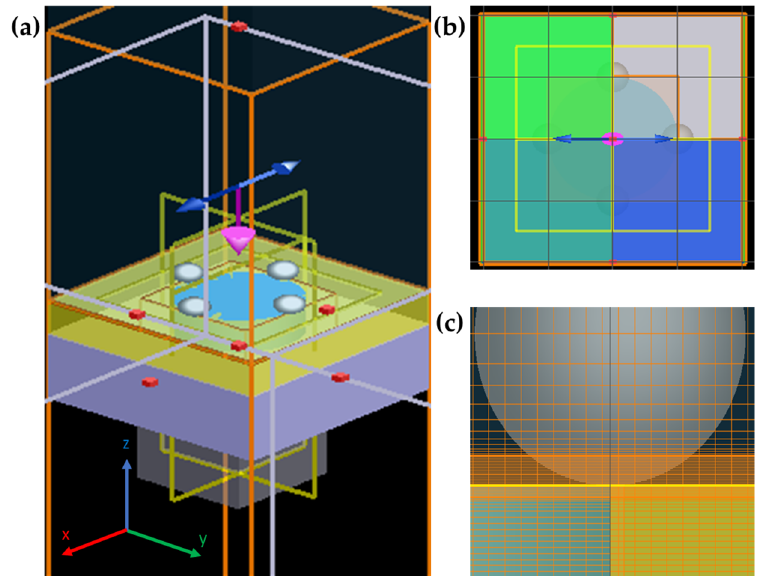
Figure 2. FDTD simulation of the hybrid SERS active nanostructure. ( a ) Perspective view of the simulation environment showing the light polarization in the x -direction. ( b ) Symmetric and antisymmetric boundary conditions were set for the x - and y directions, respectively, and a perfectly matched layer (PML) was set in the z -direction. ( c ) Override 3 nm mesh in the x - and y -axes and 0.2 nm mesh in the z -axis were set at the NHA and NP interface to improve the accuracy of the simulations in that region.